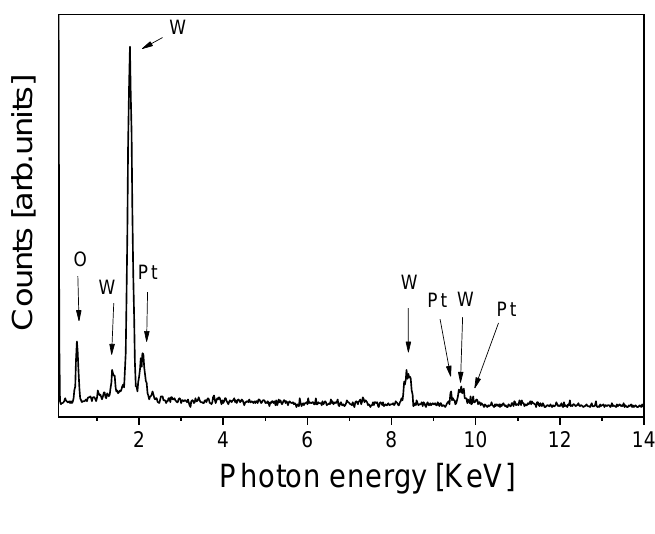
assisted with 3